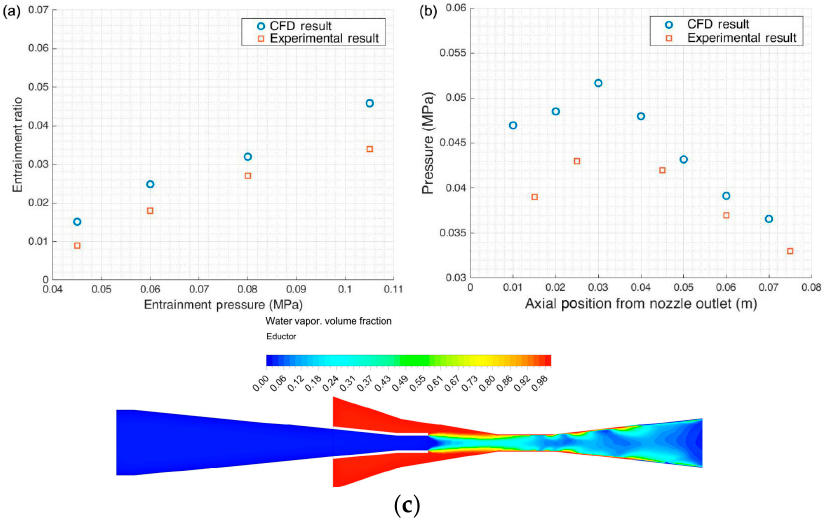
Figure 21. Comparative study of experiments Zhang et al. [22] with the current CFD method [19] .